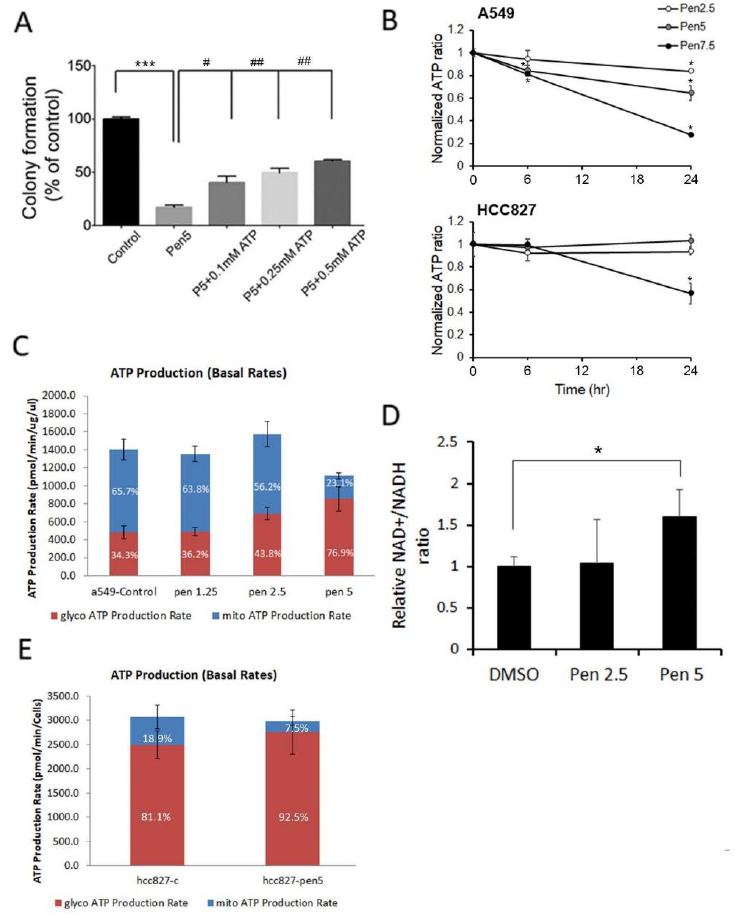
Figure 1. Effect of penfluridol on energy metabolism in human non-small cell lung cancer